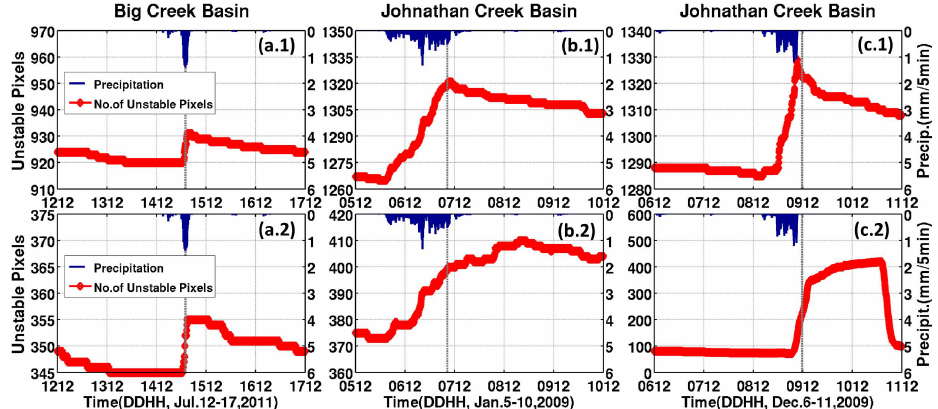
Fig. 15. The time series of the number of the total unstable pixels identified in the basins using the SSI (top) and the FS (bottom) metrics. Note that in this work, the debris flow proper is not simulated, and therefore the simulation is not representative of realistic conditions after debris flow initiation. For example, it is expected that, with mass movement, the shear stresses at locations surrounding the initiation points will decrease, and thus there should be a strong decrease in the number of unstable